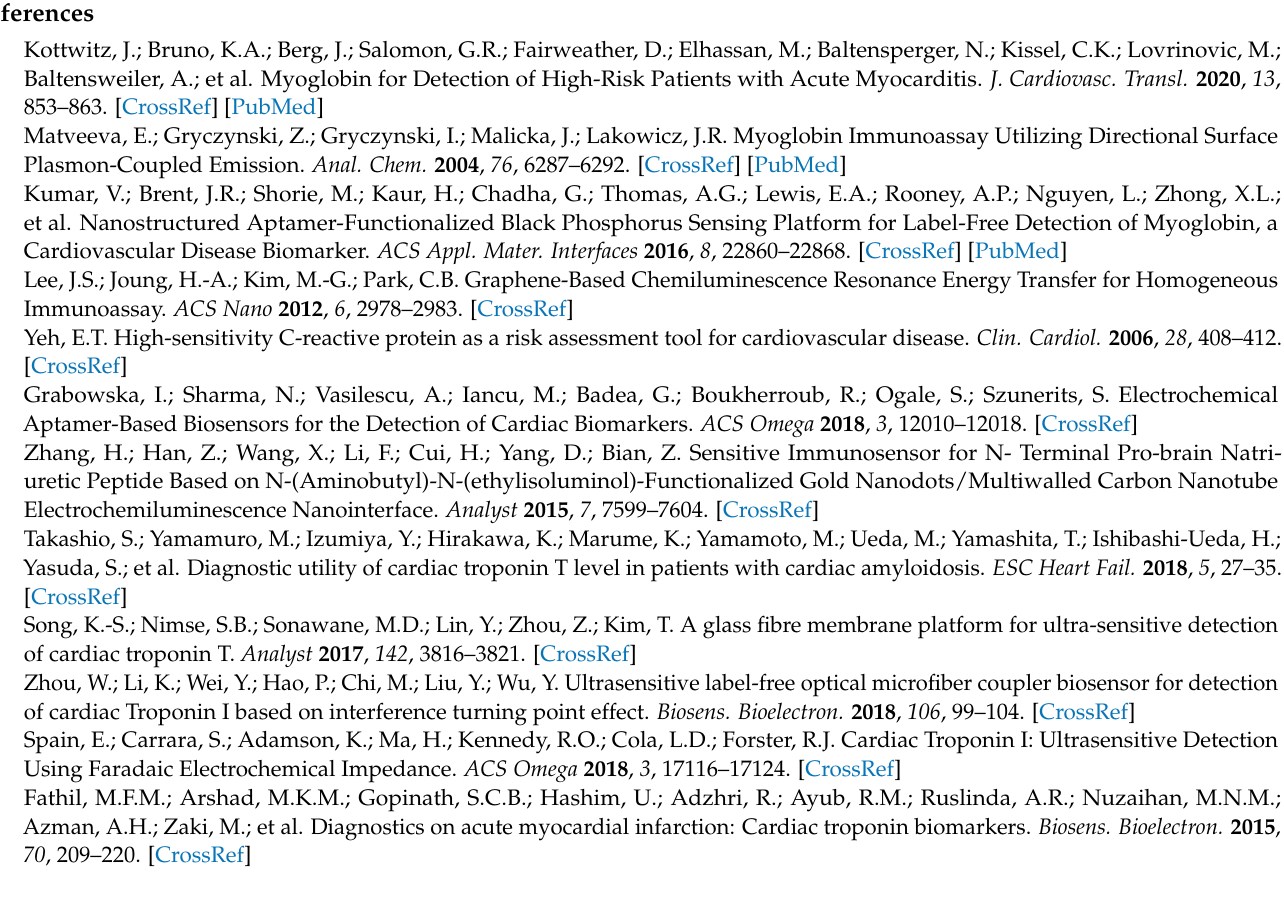
Figure S2: The curve fitting function of measured data for quantitative detection of